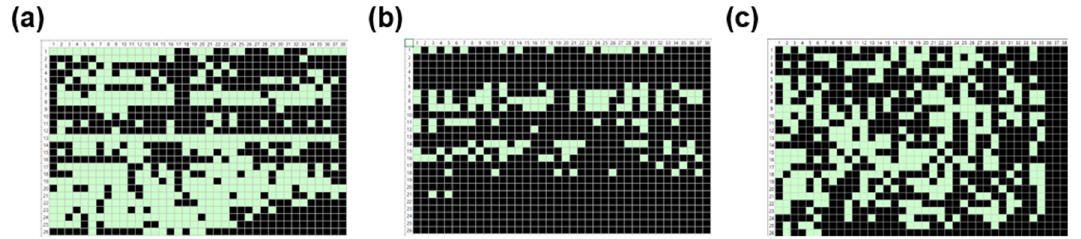
Figure 8. Statistical maps generated from PICR2R-TFT measurements of the 26 × 38 SWCNT-TFT arrays with a printing speed of 90 mm/s containing different channel lengths: ( a ) 15 µm, ( b ) 25 µm, and ( c ) 60 µm (light box: “pass”, dark box: “fail”).